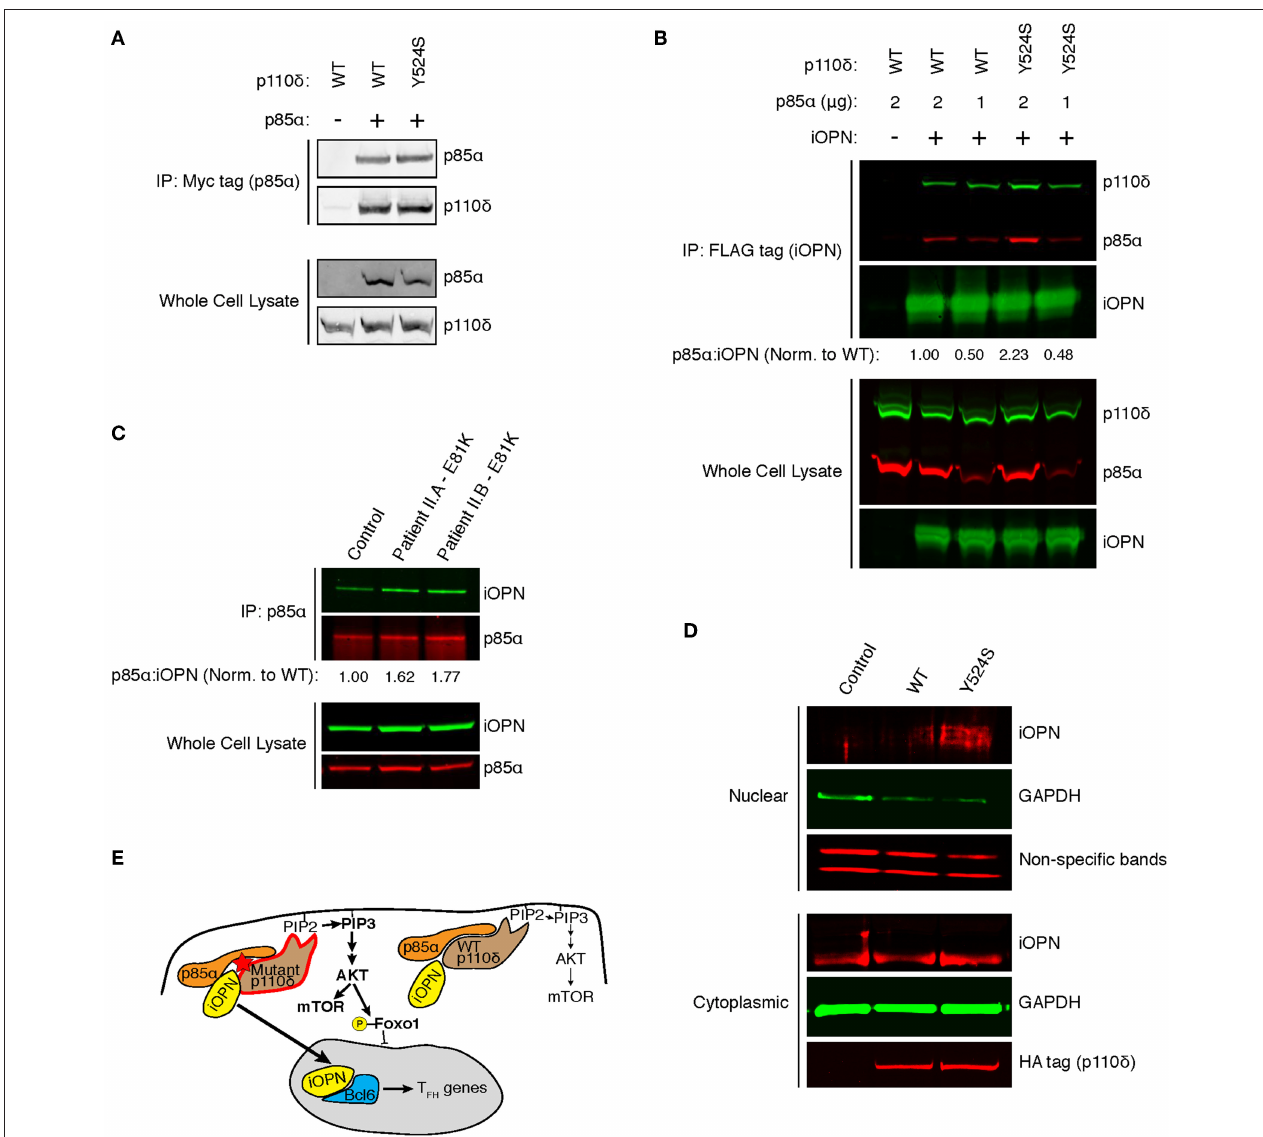
FIGURE 4 | APDS variants enhance p85 α -iOPN interactions. (A) Immunoprecipitation of WT or Y524S p110 δ with p85 α . 293T cells were co-transfected with HA-p110 δ and Myc-p85 α , and p85 α was immunoprecipitated with an anti-Myc affinity gel. Results are representative of two experiments. (B) Co-immunoprecipitation of p85 α with iOPN in the presence of WT or Y524S p110 δ . 293T cells were co-transfected with WT or variant HA-p110 δ , iOPN-FLAG and the indicated amount of Myc-p85 α . iOPN was immunoprecipitated with an anti-FLAG affinity gel. Results are representative of two experiments. (C) Co-immunoprecipitation of iOPN with p85 α from control and patient CD4 + T cell blasts. Results are representative of two experiments. (D) Intracellular OPN expression in nuclear and cytoplasmic fractions of transduced (GFP + ) cells. CD4 + T cells from a healthy donor ere transduced with WT or Y524S p110 δ . Blotting for GAPDH shows proper fractionation. Non-specific low molecular weight bands from the OPN blot show equal protein loading in the nuclear fractions. Results are representative of two experiments. (E) Model showing that enhanced interaction of iOPN with p85 α in the presence of the variant p110 δ drives T FH